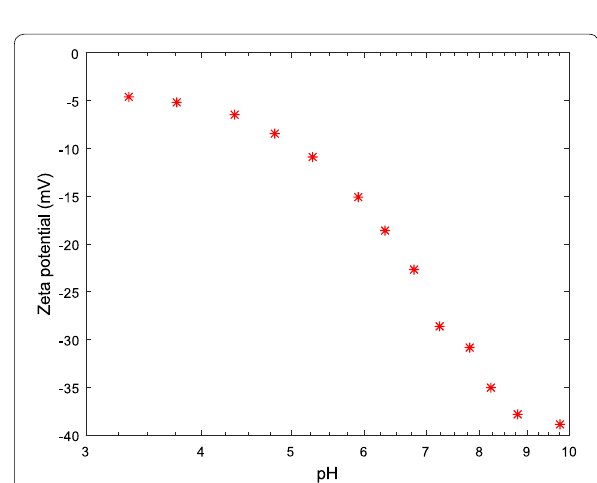
Fig. 3 Zeta potential change with pH for Ludox ® TM-40 silica sol. The graph shows a clear trend where zeta potential decreases with increase in